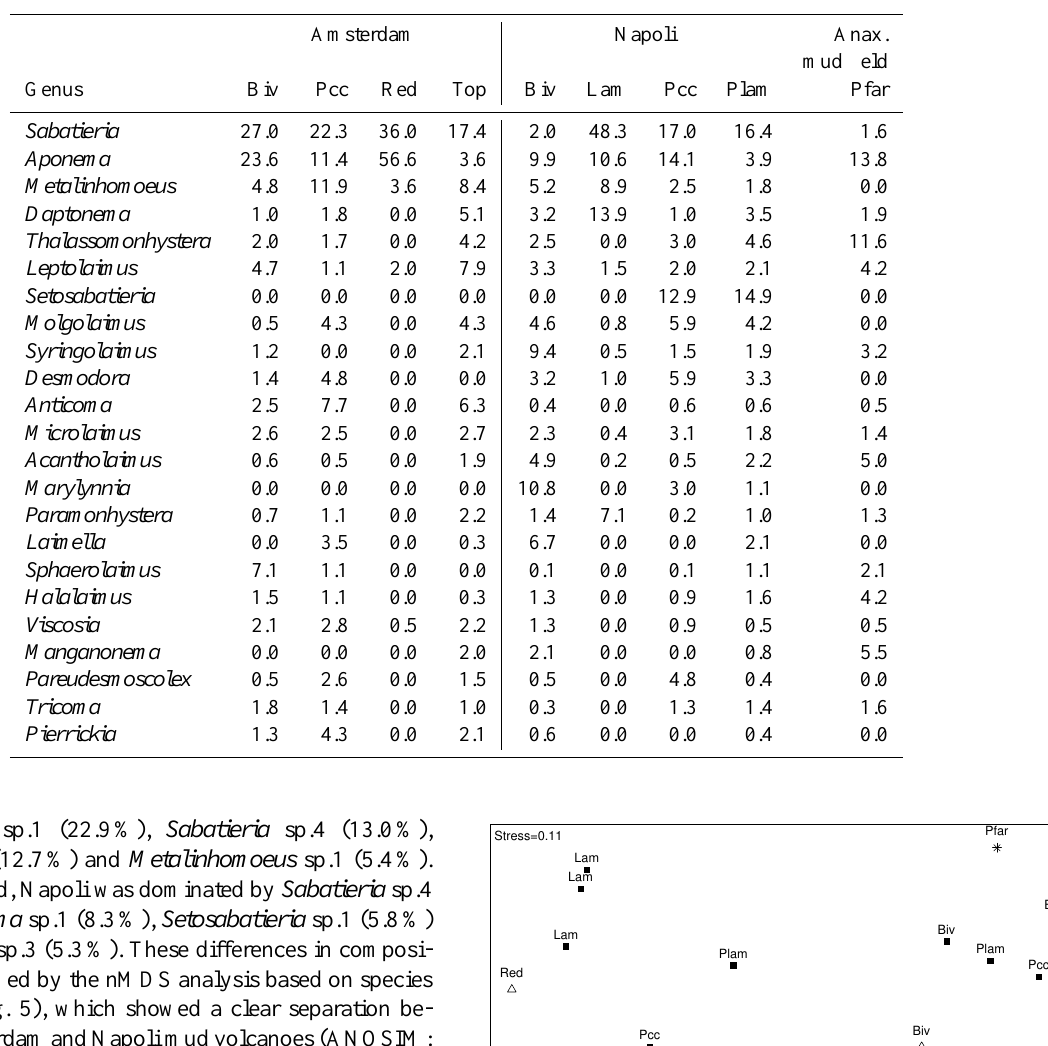
Table 4. Relative abundance of nematode genera contributing, on average, with more than 1% to the total abundance (Biv: bivalve shells; Pcc: periphery of carbonate crusts; Red: reduced sediments; Top: summit of the mud volcano; Lam: Lamellibrachia microhabitat; Plam: periphery of Lamellibrachia ; Pfar: far periphery).